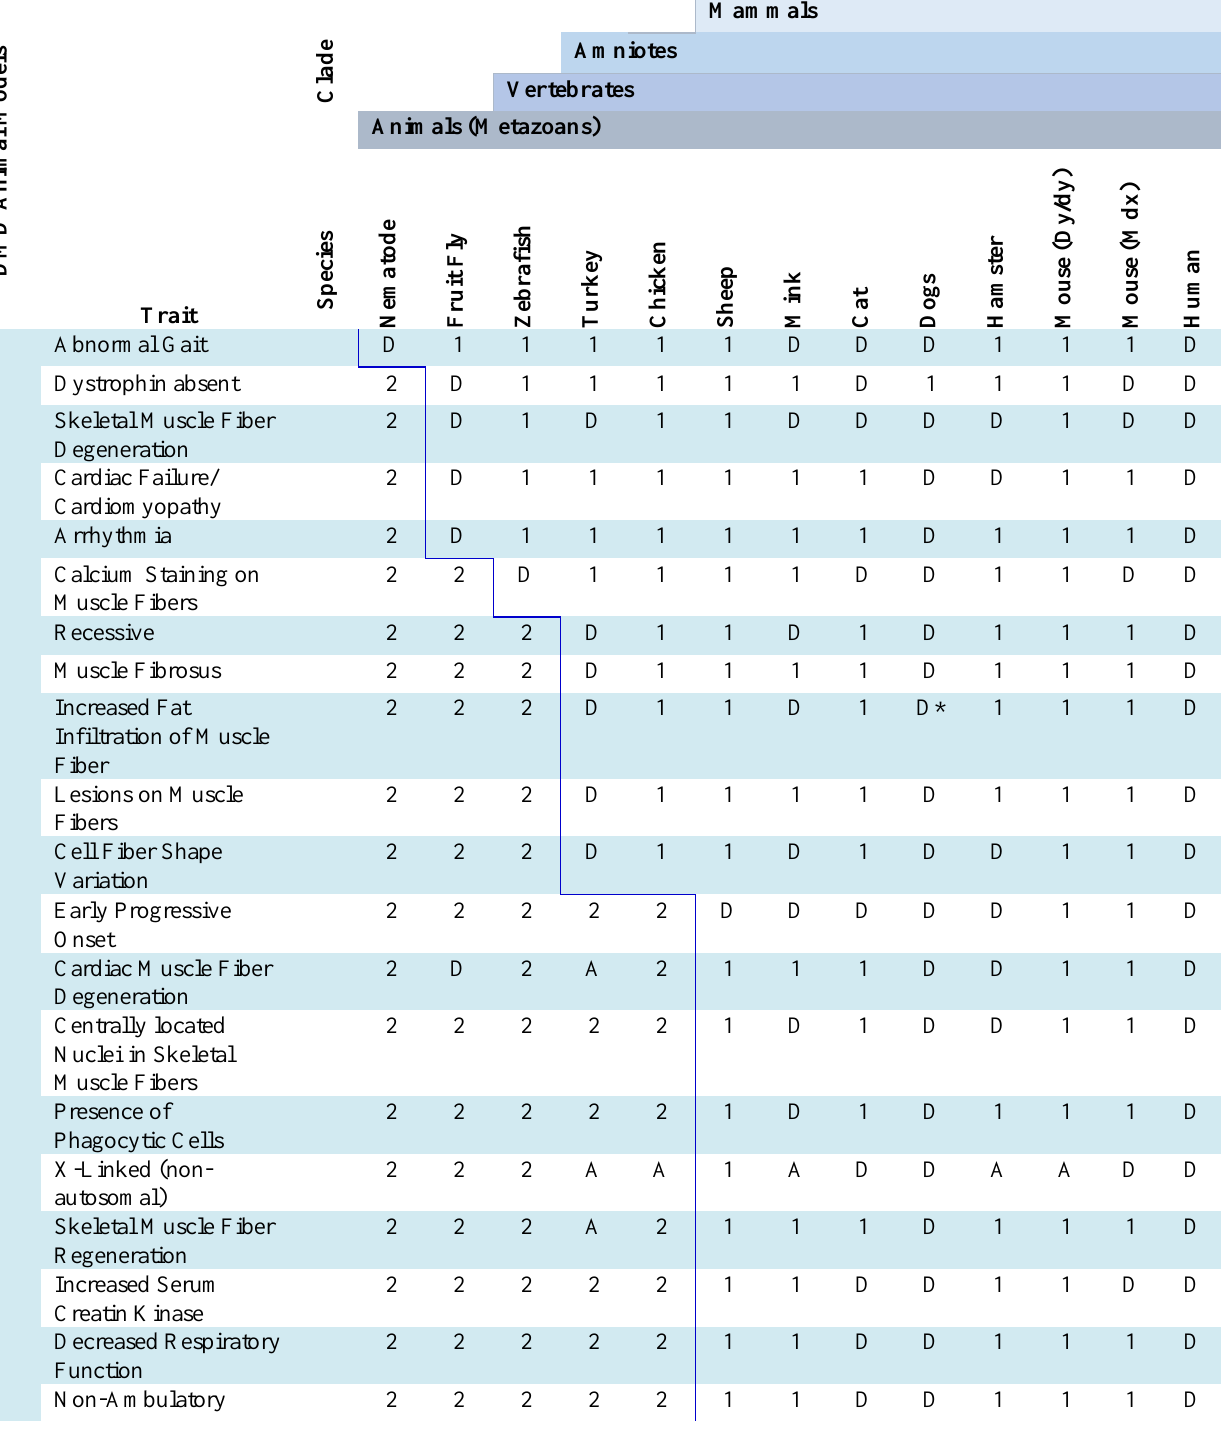
Table 2. DMD. Documented and inferred character states for symptomatic traits among DMD model animals. Blue line indicates phylogenetically lower level limits of Level 1 inferences (highest confidence) or Documented symptoms. Key: D = documented symptom; A = documented absent symptom; 1 = Level 1 inference; 2 = Level 2 inference. Dogs are treated as a single case, though the condition has been identified in ten breeds of dog which exhibit variation in some traits (data not shown). Data were extracted from sources indicated (*) in the